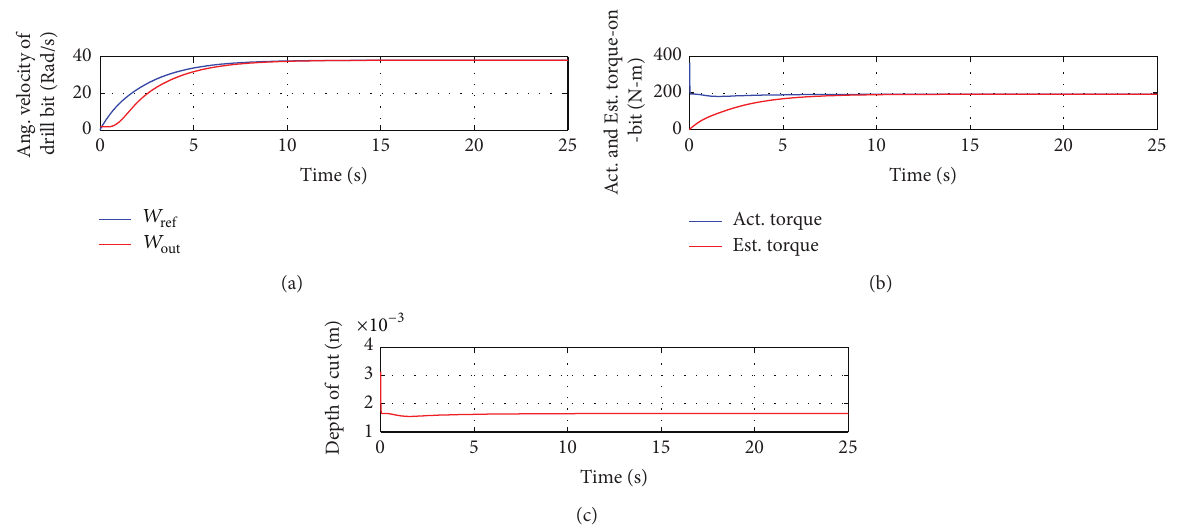
̂𝑇(𝑡) (b), and the depth of cut 𝑑(𝑡) (c)